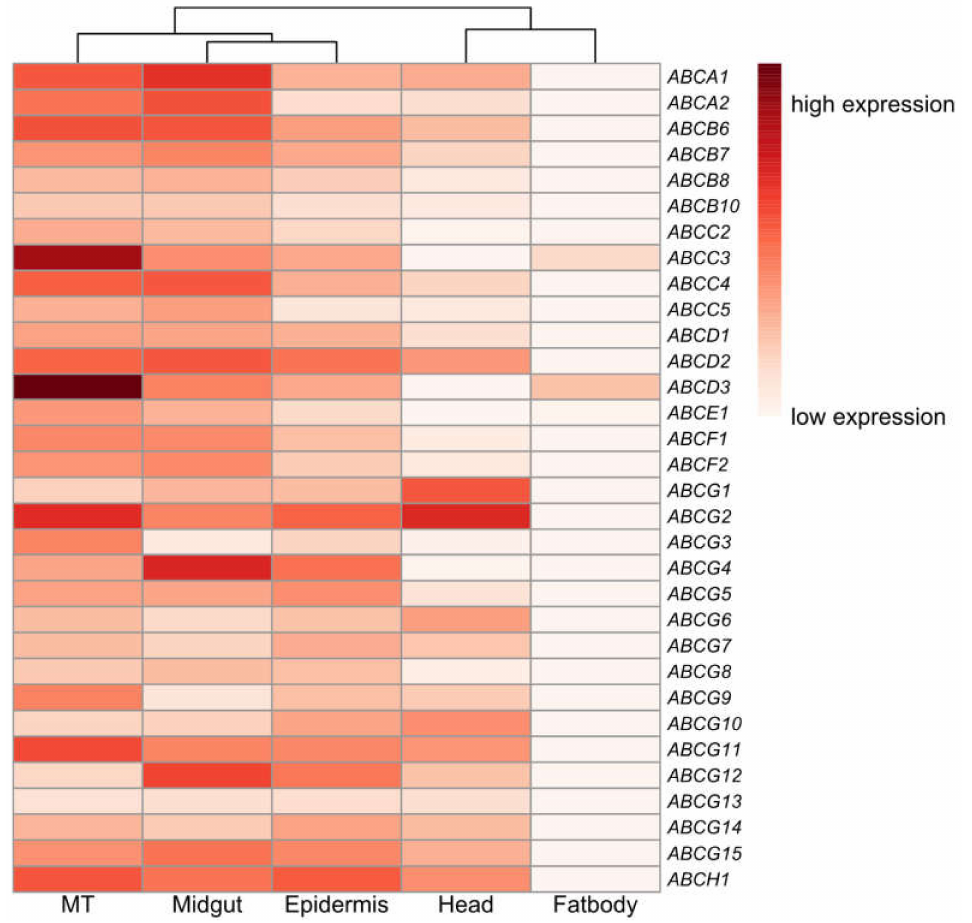
Figure 3. Relative expression levels of ABC transporters in di ff erent tissues of 5th instar N. lugens , as determined by qRT-PCR. Letters on the right are the gene names for the 32 ABC transporters. Tissue types are given at the bottom; MT, Malpighian tubules. The mRNA levels, represented by normalized log10 ( ∆ CT) values, are shown in the gradient heatmap. The color from light to dark indicates the expression level from low to